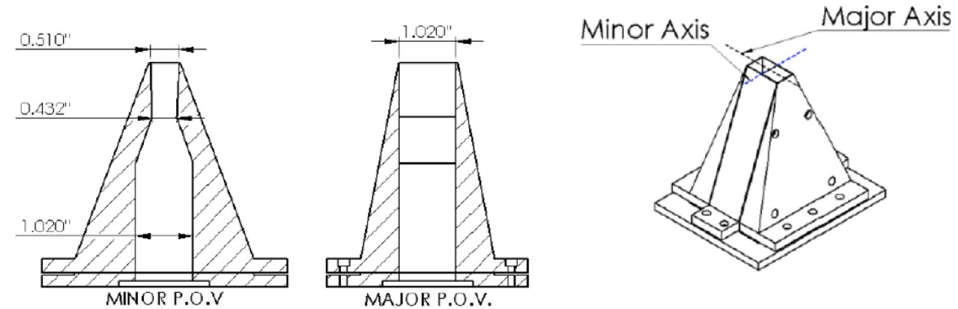
Figure 1 . Rectangular nozzle geometry taken from [60], dimensions in inches. Figure 1. Rectangular nozzle geometry taken from [60], dimensions in